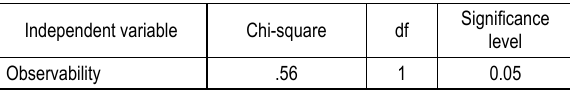
Table 5. The results of test of the relationship between observability of solar water heater and adoption